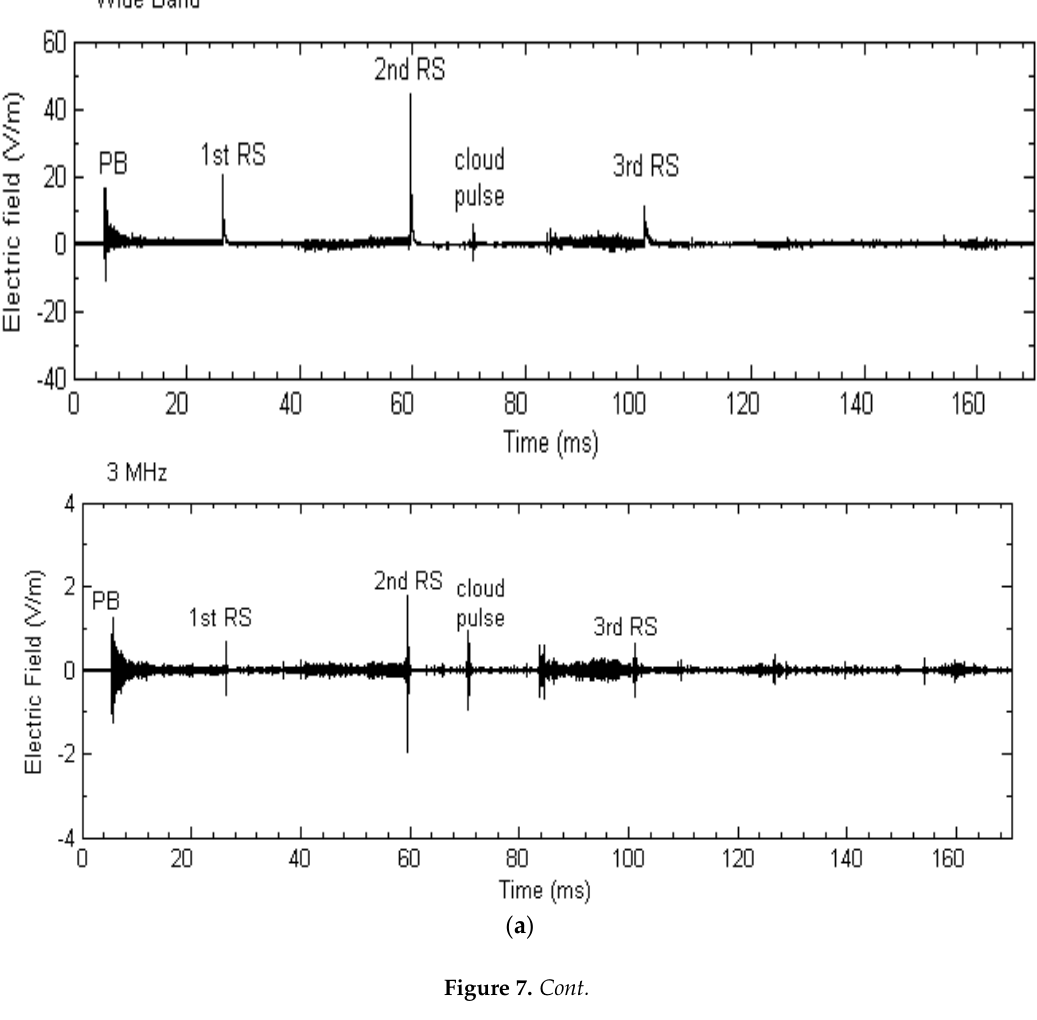
Figure 7. Cont. Figure 7.